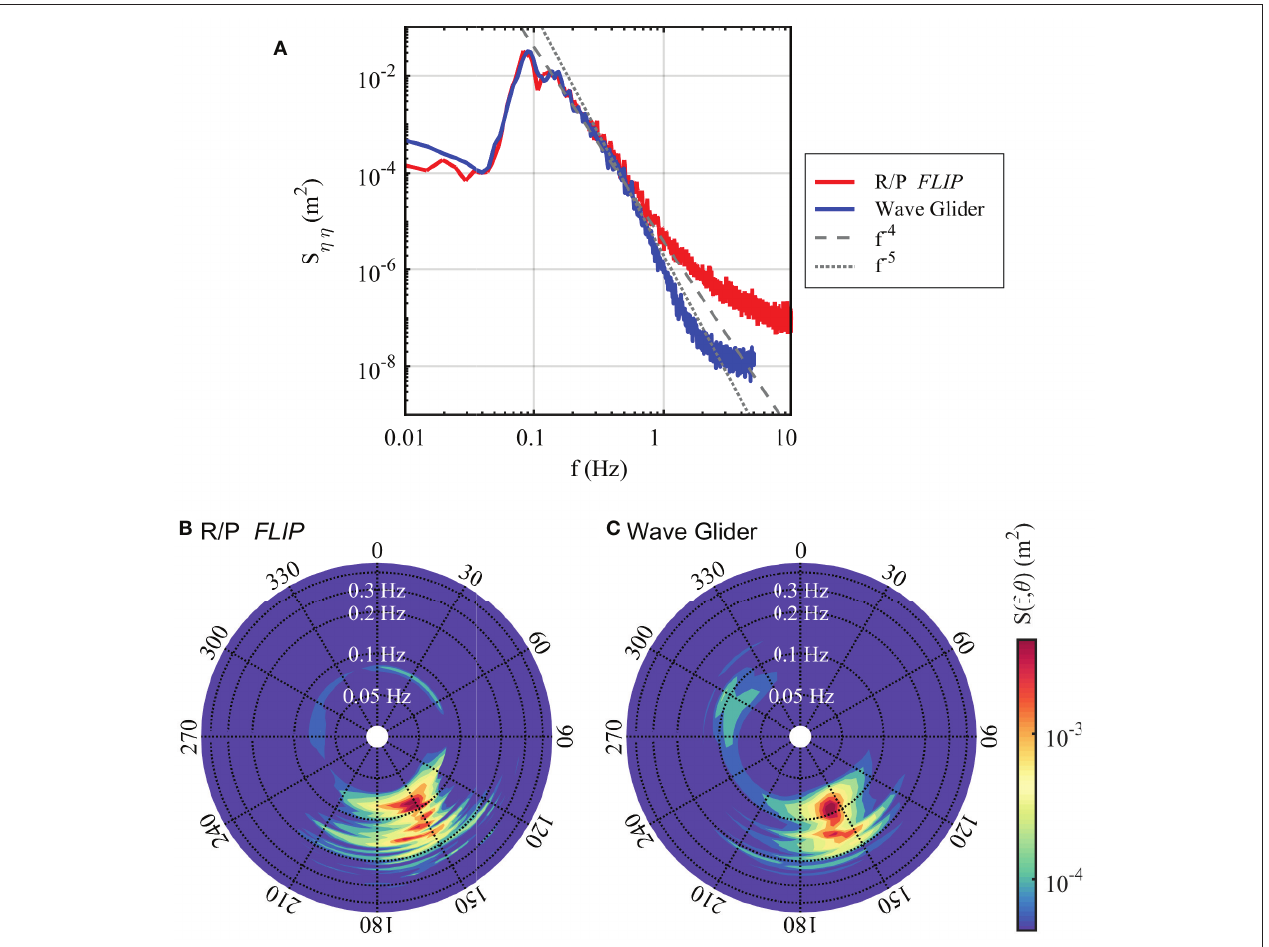
FIGURE 4 | (A) Comparison of the omni-directional wave spectra measured from the R/P FLIP (red) and the SV2 Wave Glider Kelvin (blue) from the 30 min record starting at 2300 UTC 31 March 2017 during LCDRI2017 while the wind was blowing at 8.1 m s − 1 . For the R/P FLIP , S ηη is computed from the surface displacement measured by a single laser wave gauge, while for the Wave Glider, the surface elevation is assumed to be described by the vertical displacement (heave motion) of the Wave Glider. There is good agreement between the two platforms in the frequency range [0.04, 0.6] Hz. (B,C) Comparison of surface wave directional spectra measured from the R/P FLIP and the SV2 Wave Glider Kelvin during the same 30 min record as in (A) . For the R/P FLIP , the directional spectrum was derived from the array of single point laser wave gauges mounted on each of the R/P FLIP booms. For the Wave Glider, the directional spectrum was derived from the three components of the Wave Glider velocity. Both directional spectra are computed using the WAFO toolbox. Frequency increases radially outward following a logarithmic scale from the center of each plot, with the color scale depicted as the log of the energy